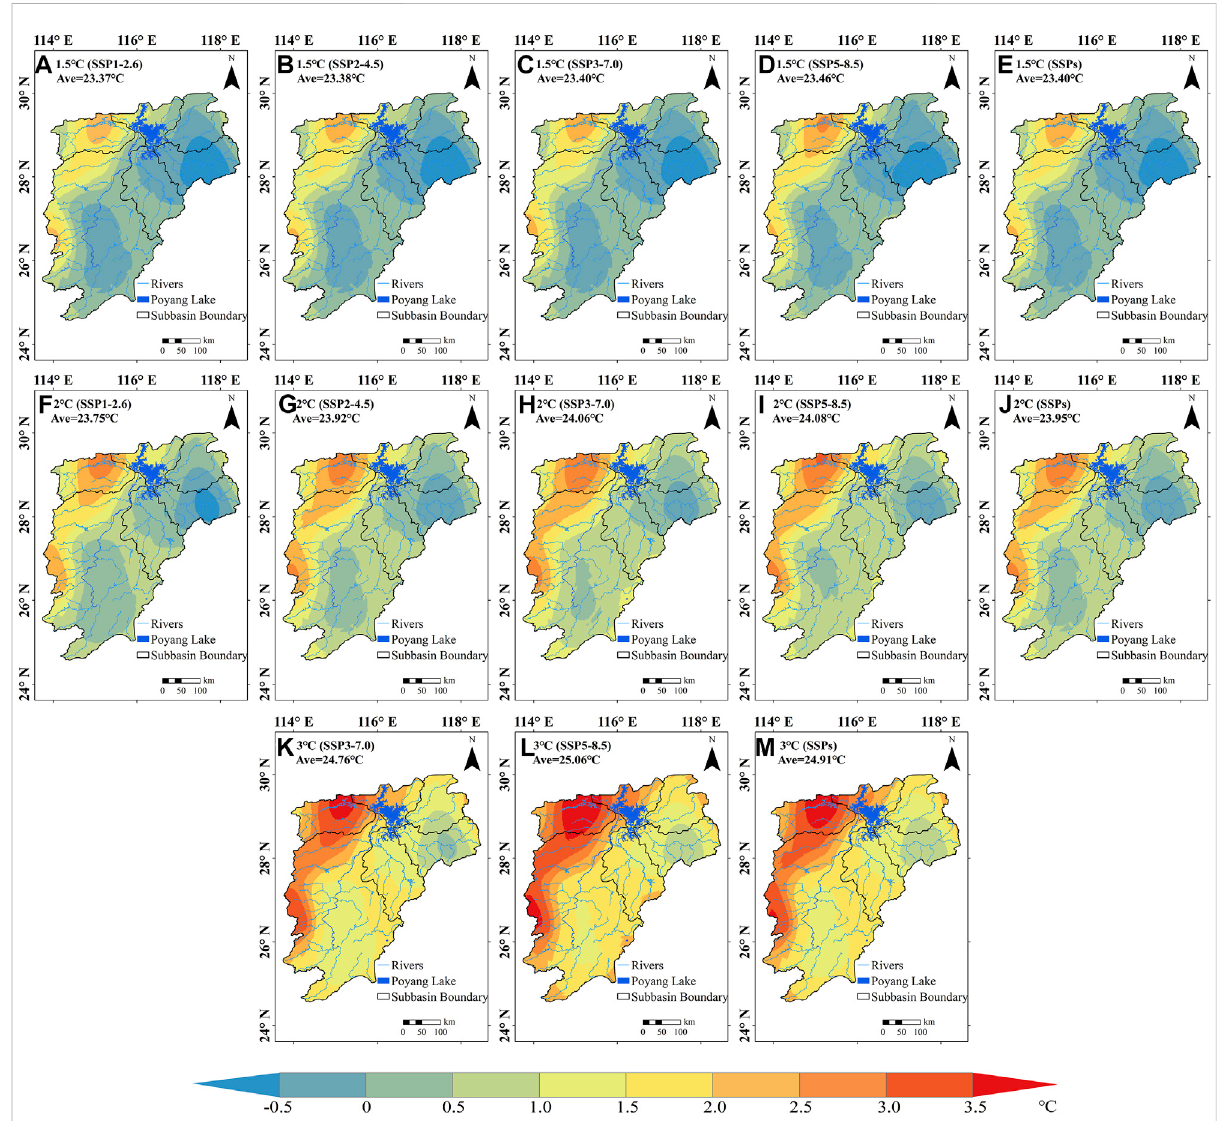
FIGURE 10 Spatial distribution of Tasmax in the PLB relative to the reference period (1986 – 2005). (A – E) are the 1.5 ° C global warming target. (F – J) are the 2 ° C global warming target. (K – M) are the 3 ° C global warming target. (E,J,M) are the emission scenarios averaging